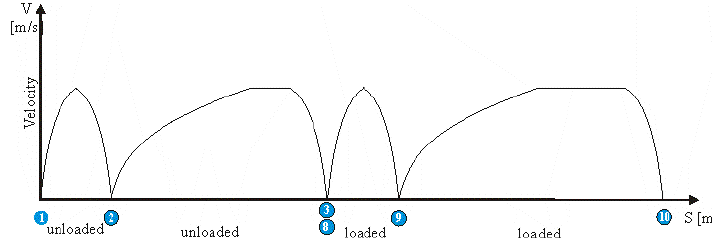
Figure 4. A model run of a forklift. Forces that cause load damage are defined in Section 4 of the